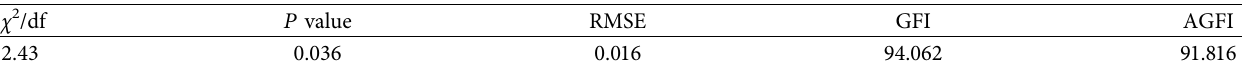
Table 4: Goodness of fit indices of financial